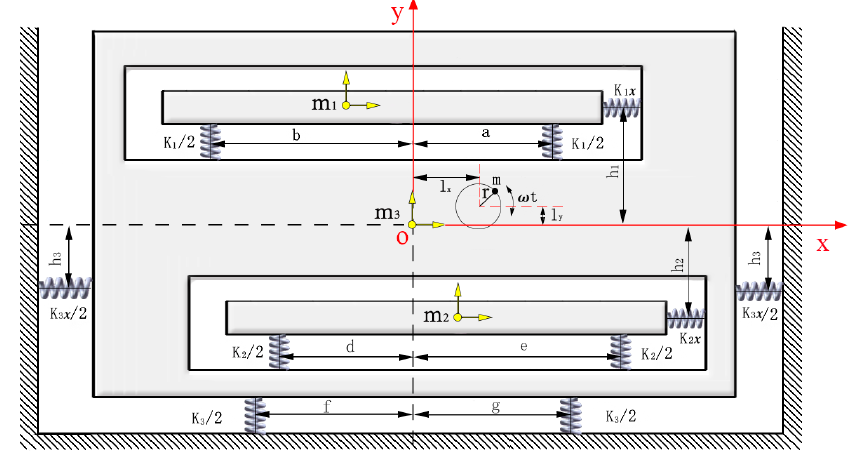
Figure 2. Schematic diagram of double-deck vibrating flip-flow screen structure.